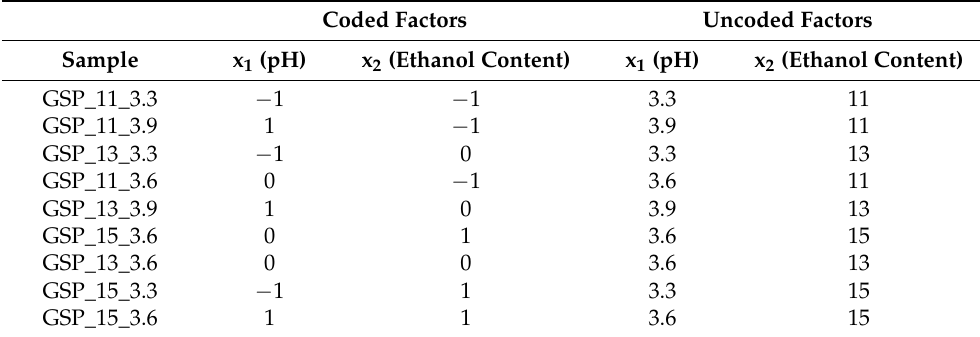
Table 1. Description of experimental Syrah red wines according to the wine pH and ethanol content (% v / v ) factors and their levels in the full factorial design.